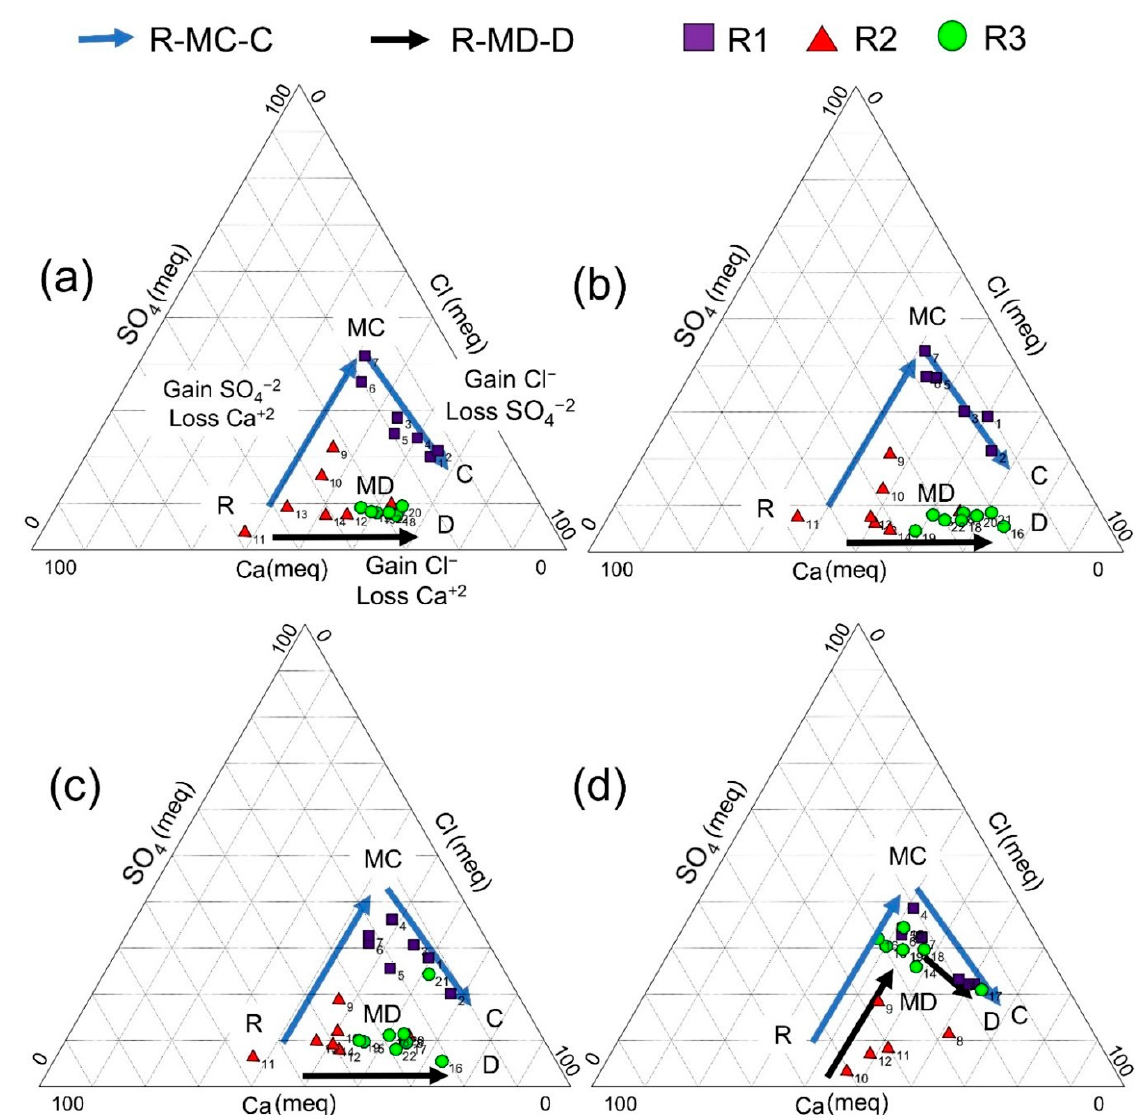
Figure 3. Ternary diagram of calcium, chloride and sulfate (Ca +2 , Cl − , SO 4 − 2 ) and their gain trajectories in the RC. ( a ) SP1